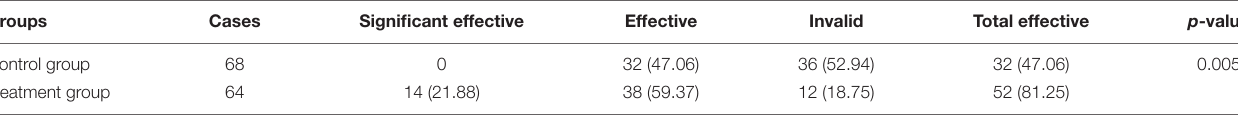
TABLE 7 | The comparison of therapeutic effectiveness between two groups [Cases (%)].